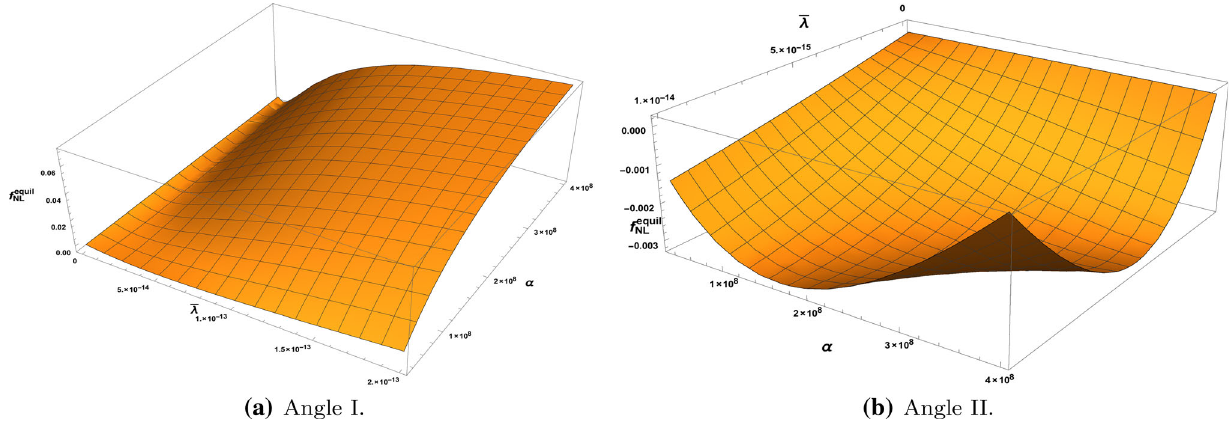
Fig. 13 Representative 3D diagram for equilateral non-Gaussian three point amplitude vs. the model parameters α and ¯ λ for N cmb = 60 in two different angular views